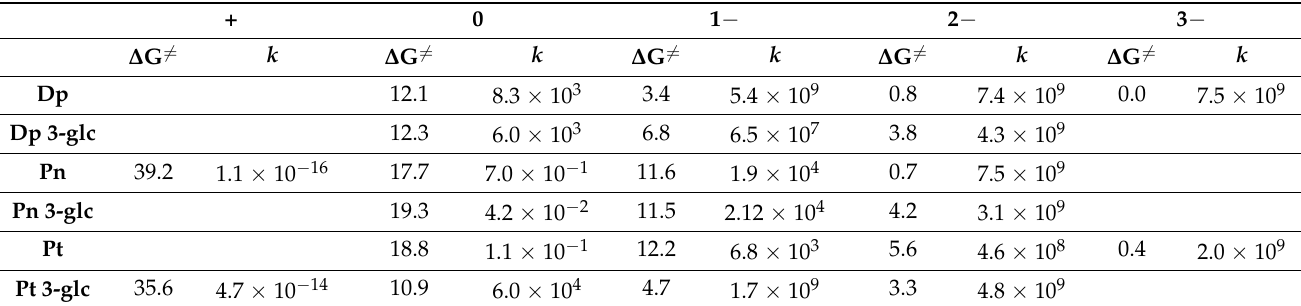
Table 5. Activation energies ( ∆ G (cid:54) = , in kcal mol − 1 ) and kinetic constants (k, in M − 1 s − 1 ) of SET reactions between the anthocyanidins’ and the anthocyanins’ species and DPPH • in